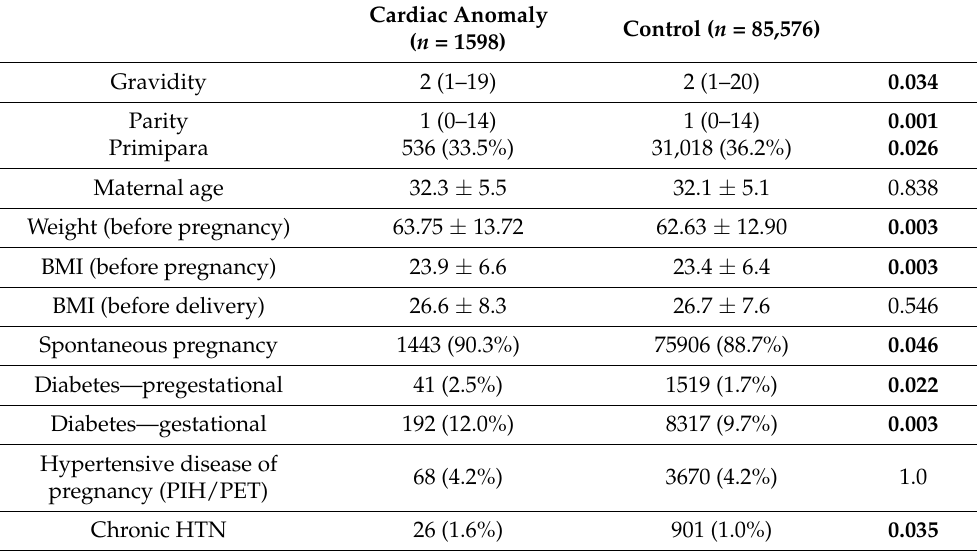
Table 1. Characteristics of 87,174 deliveries > 24 0/7 weeks. Comparison between controls and fetuses with congenital cardiac anomalies. Cardiac Anomaly ( n =